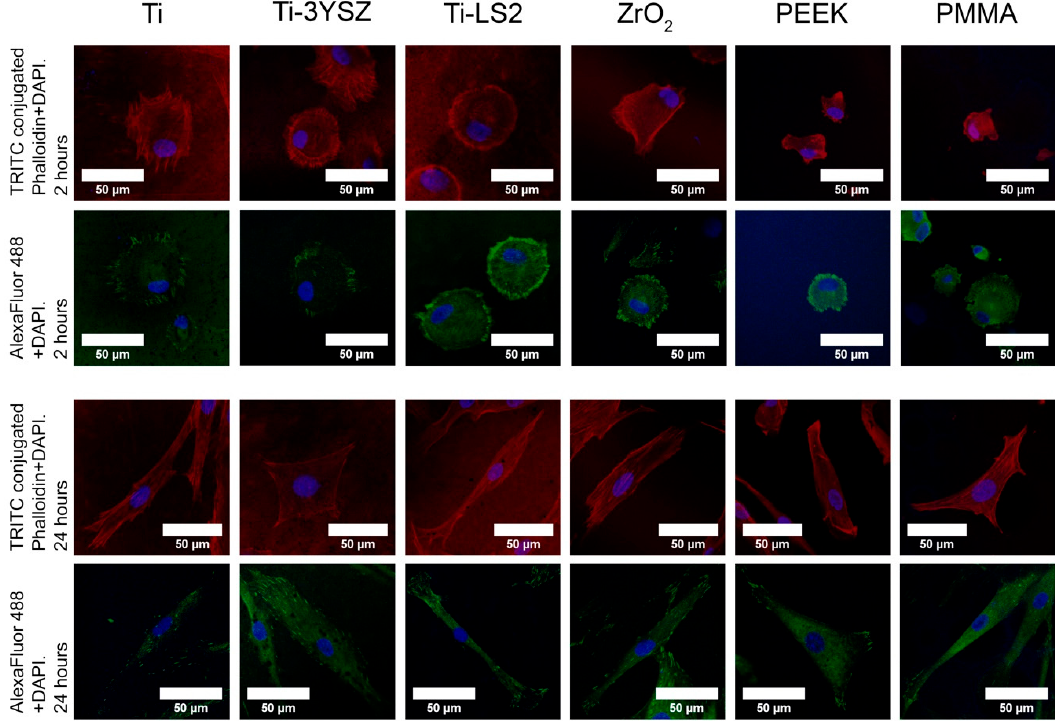
Figure 4. Confocal laser scanning microscope (CLSM) images of immunohistochemically stained cells on surface coatings at a different time (2 and 24 h). HGF-1 nucleus (DAPI (4’,6-diamidino-2-phenylindole), blue), F-actin filaments (tetramethyl rhodamine iso-thiocyanate (TRITC)-conjugated phalloidin, red), and focal adhesion (FA) spots (vinculin stained with Alexa Fluor 488-conjugated antibodies, green).